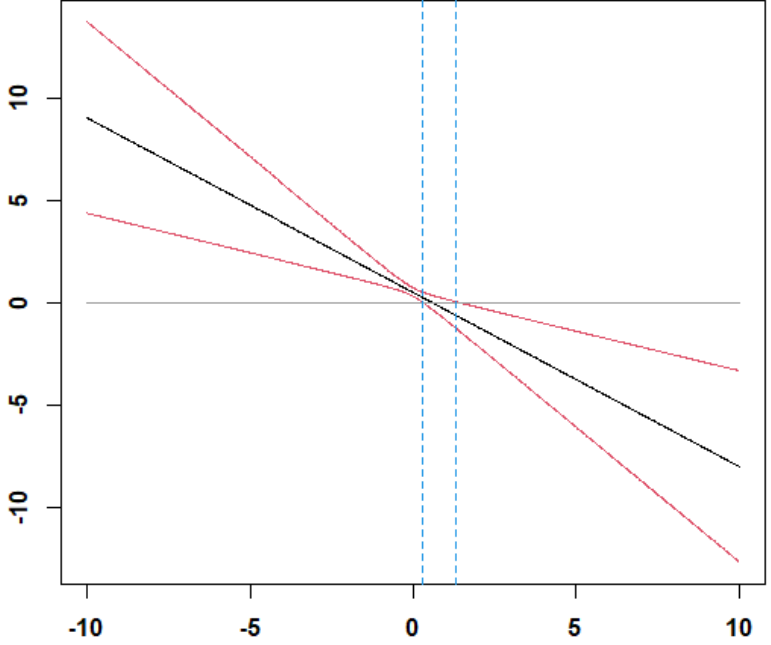
Figure 3. The region of significance of the moderating effect of group average competency. Note: The moderating effect is significant when the moderator is greater than 1.33 and smaller than 0.29. X-axis: Moderator, Y-axis: Simple slope.